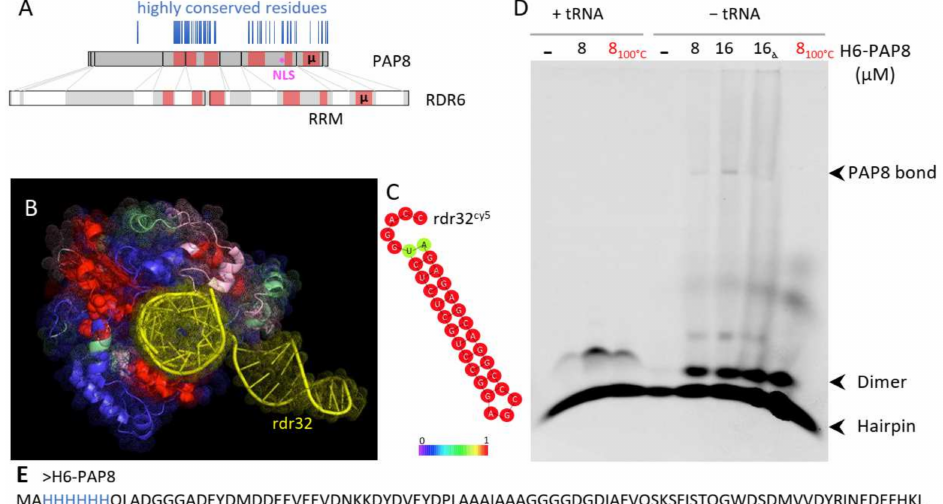
Figure 5. PAP8 microhomology to RDR6 reveals RNA binding domains. ( A ) Domain mapping on the amino acid sequence of PAP8 according to the structural homology comparison with RDR6 (pdb:4K50) using T-coffee expresso. Highly conserved residues in the PAP8 orthologous family of proteins are represented as vertical blue lines; µ , amino acid microhomology between PAP8 and RDR6; RRM, RNA recognition motifs in RDR6. ( B ) Amino acid painting of the three-dimensional fold of RDR6 according to the homology with PAP8: red, good; pink, average; green, bad; blue, absent in PAP8 and yellow, double-stranded RNA sequence named rdr32 hereafter. ( C ) RNAfold server prediction for the topology of rdr32 RNA sequence used as a cy5-marked probe. ( D ) RNA electromobility shift assay rEMSA using rdr32cy5 as RNA probe and H6-PAP8 produced in E. coli ; 8 100 ◦ C , boiled PAP8 protein prior to setting the interaction assay with the probe; 16 α , 16 µ M of PAP8 + PAP8 antibody (5% of 10,000 × ). ( E ) Recombinant H6-PAP8 amino acid sequence; histidine tag in blue; homology regions with RDR6 in red; microhomology underlined and NLS in